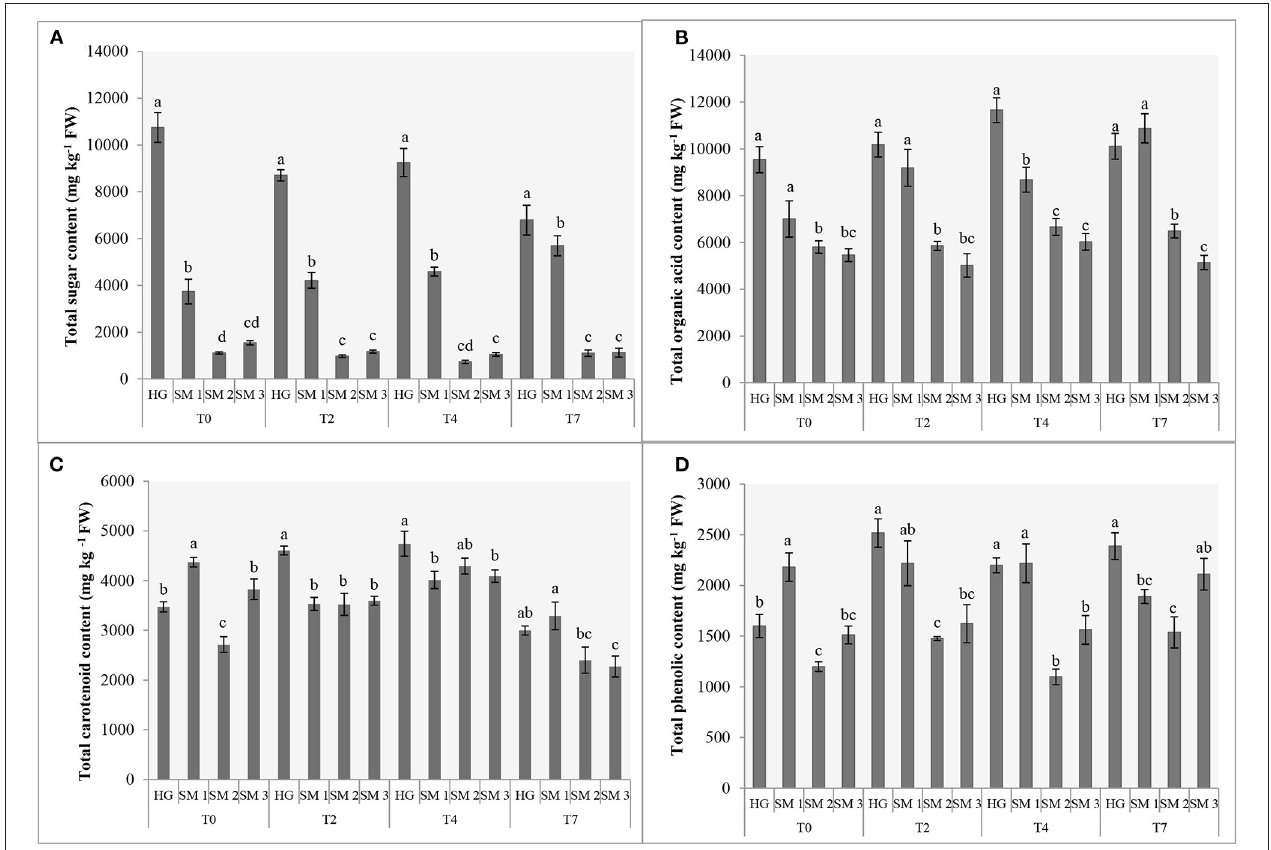
FIGURE 1 | Sums (mg kg − 1 FW) of sugars (A) , organic acids (B) and carotenoids (C) and total phenolic content (D) of different sources of lamb’s lettuce subjected to refrigerated storage (T0, prior to storage; T2, 2 days in refrigerated storage; T4, 4 days in refrigerated storage; T7, 7 days in refrigerated storage). Different letters (a-d) above bars denote statistically significant differences in each parameter among V. locusta “Vit” sample sources by Duncan’s multiple range test at P < 0.05 separately for each sampling. Standard errors (SE) are presented with bars within each